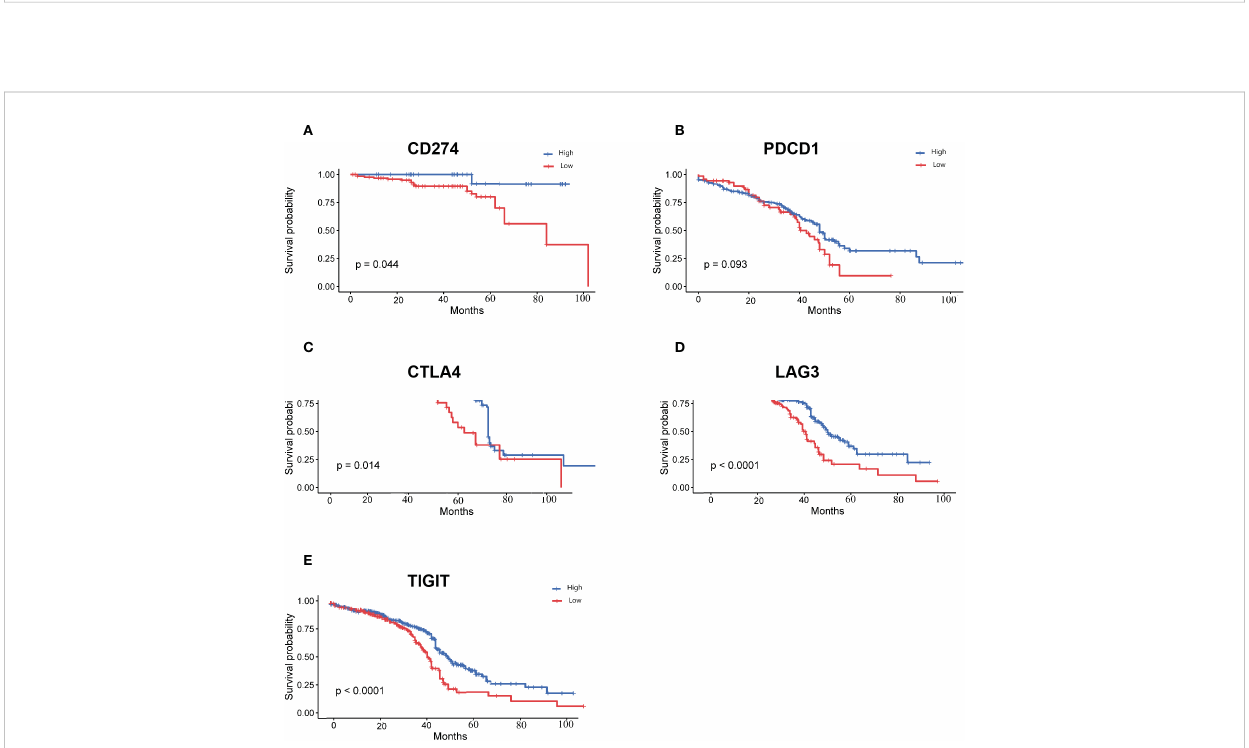
FIGURE 5 Survival curves for high and low expression groups of immune-associated differentially expressed genes (A) : Survival curves for high and low expression groups of CD274; (B) : Survival curves for high and low expression groups of PDCD1; (C) : Survival curves for high and low expression groups of CTLA4; (D) : Survival curves for high and low expression groups of LAG3; (E) : Survival curves for high and low expression groups of